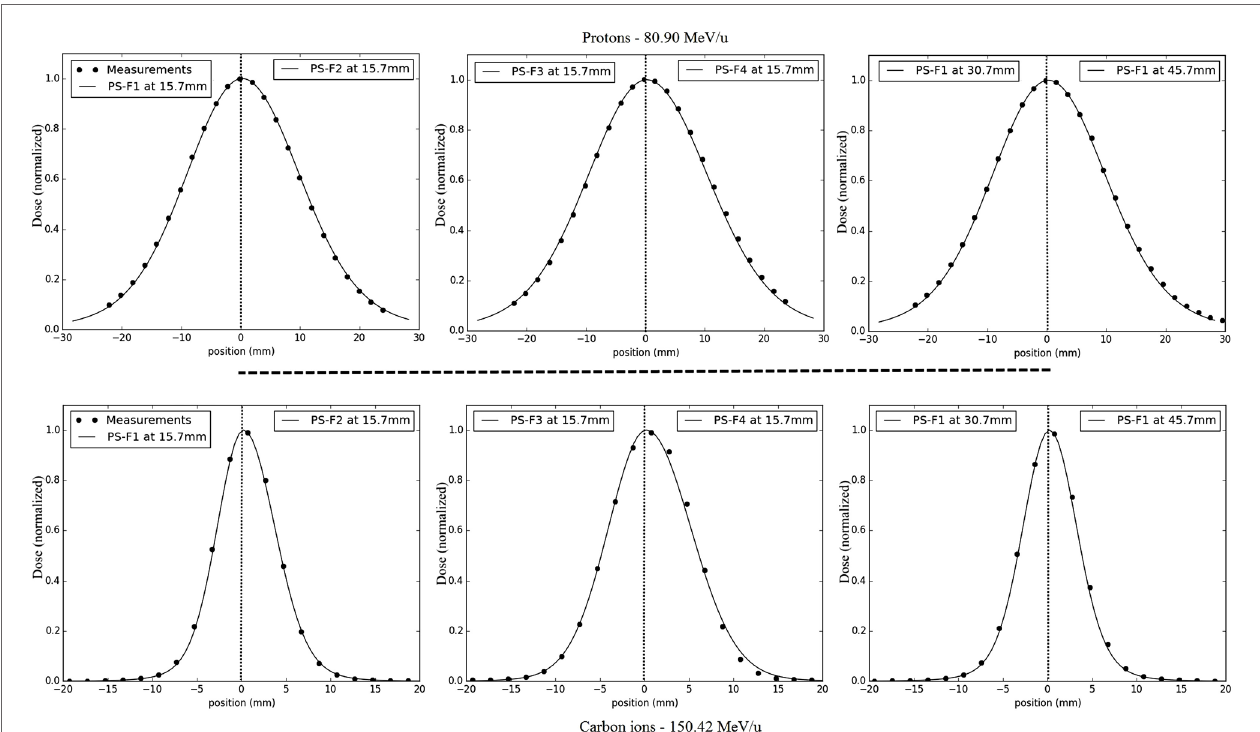
FigUre 8 | Dose calculations and measurements for lateral dose profile comparisons from line scans: half-profiles of the different foci are plotted for the same low energy, from left to right for focus 1 to focus 4 at 15.7 mm in water, and for two other depths for focus 1 (30.7 and 40.7 mm); the upper panels correspond to protons comparisons (energy 80.90 MeV/u), the bottom panels to carbon ions comparisons (energy 150.42 MeV/u); results are normalized to the